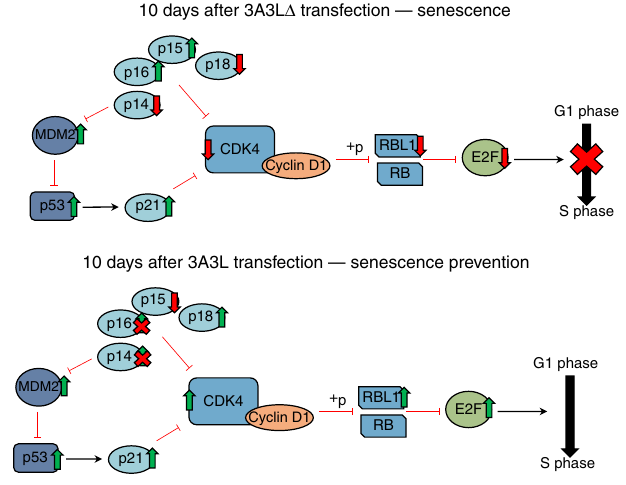
Fig. 7 Model of epigenetic editing mediated senescence prevention. A schematic showing the main transcriptional changes that occur 10 days after DNA methylation is targeted to CDKN2A by dCas9 3A3L which prevents senescence